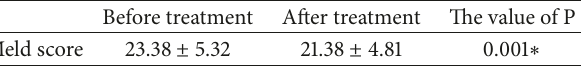
Table 5: Meld score analysis of liver failure treated with nonbioar- tificial liver